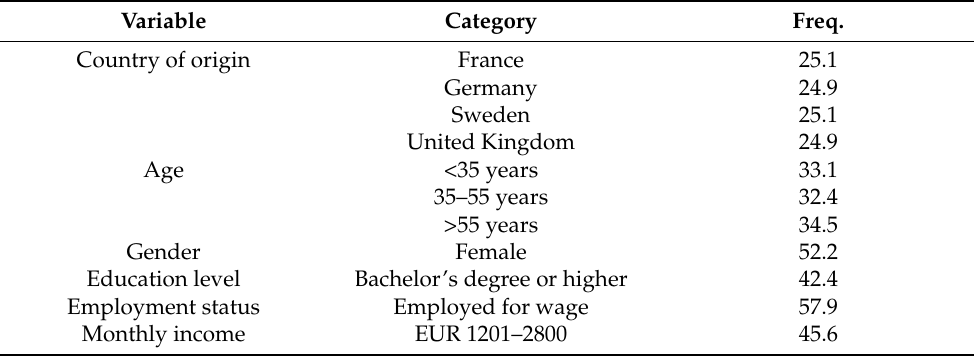
Table 3. Socio-economic characteristics of tourists.